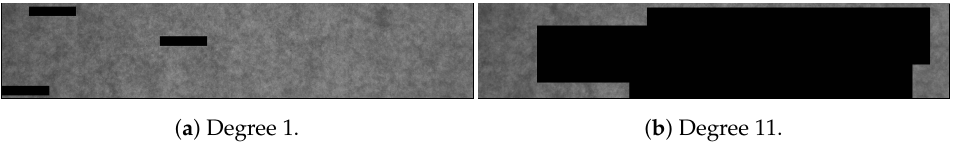
Figure 6. Examples of altered documents with simulations of stain damage; in particular ( a ) repre- sents the first degree of damage while ( b ) the last (e.g., 11).